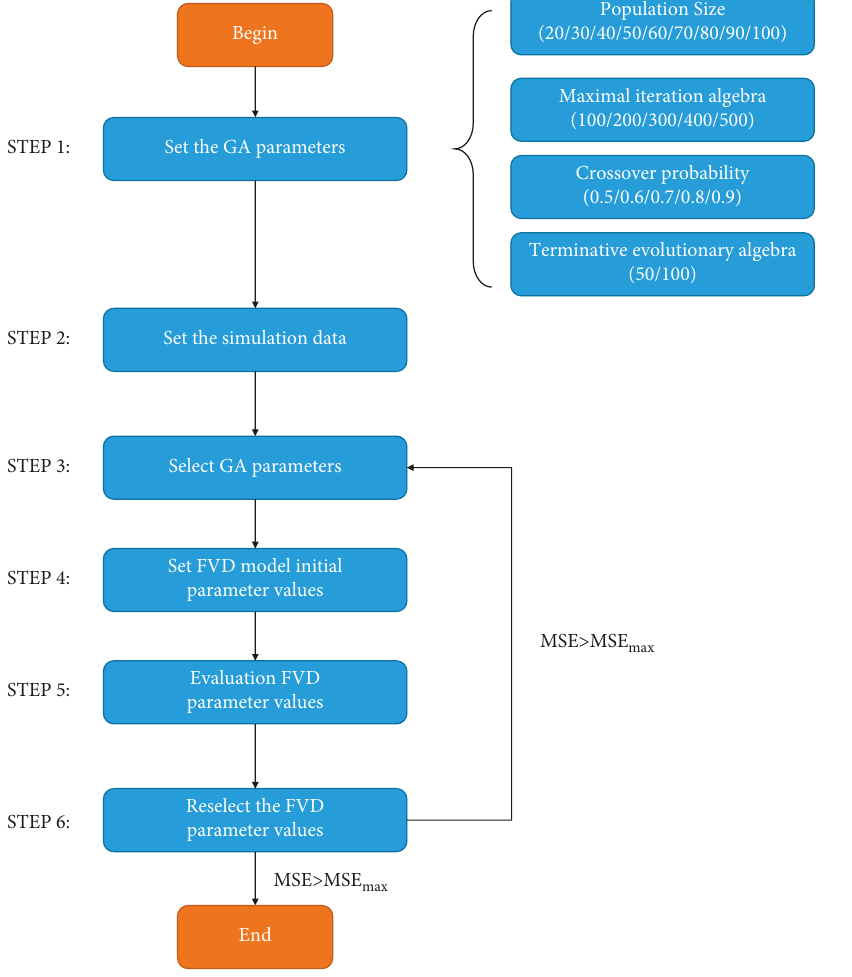
Figure 4: Genetic algorithm flow chart.